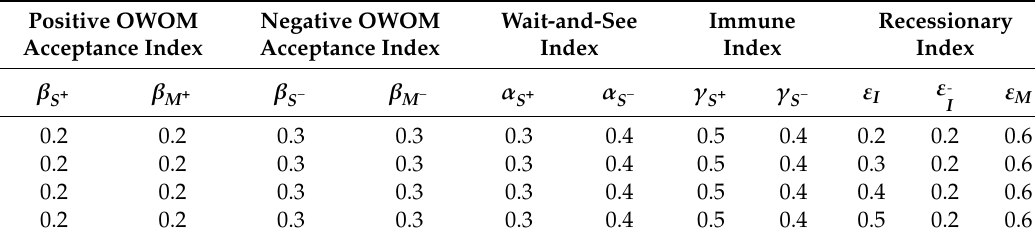
Table 7. Simulation Experiment 4 parameter setting.